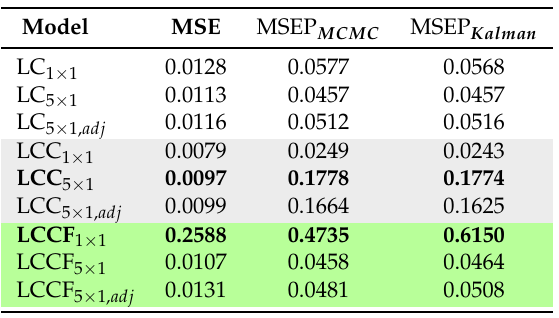
Table 5. Mean square error of the fit of the models to the data (MSE) and mean square errors of predictions using forecasting distributions given by MCMC samples (MSEP MCMC ) and Kalman Filter (MSEP Kalman ). The models highlated by bold font exhibit significant levels of